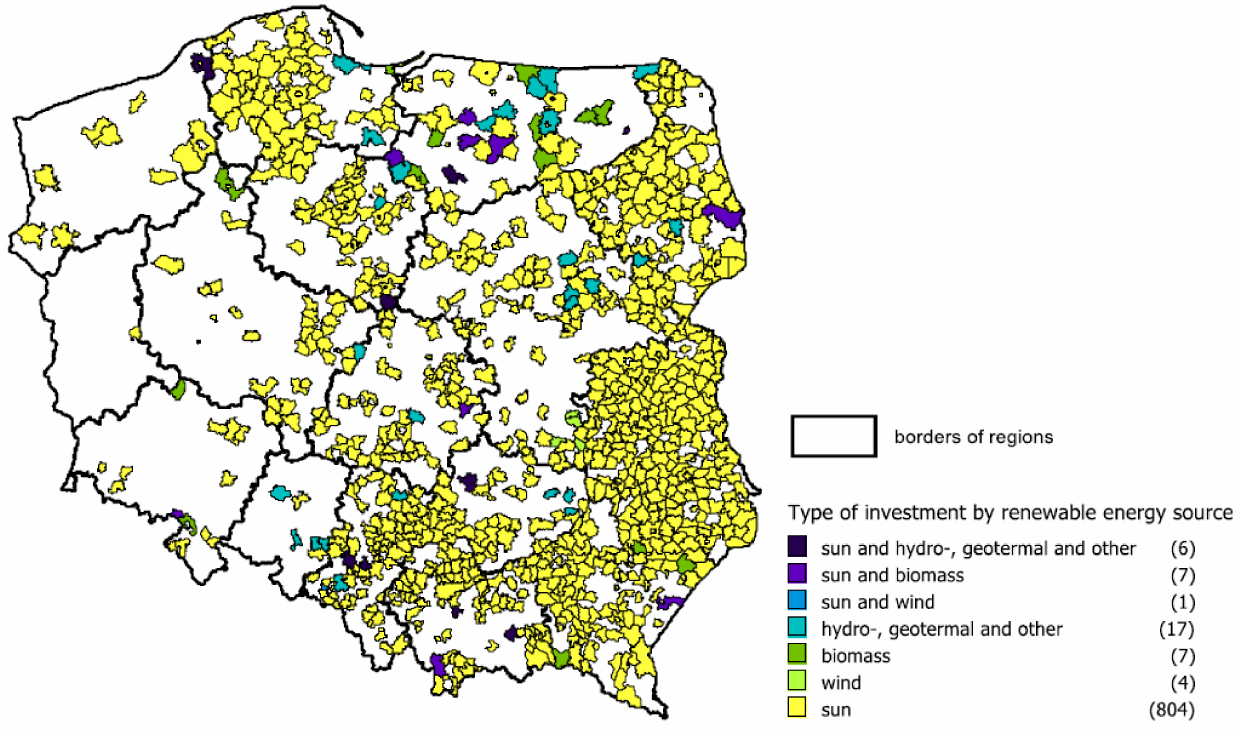
Figure 2. Location of renewable energy projects carried out by local authorities under operational programs 2014–2020 by the source of renewable